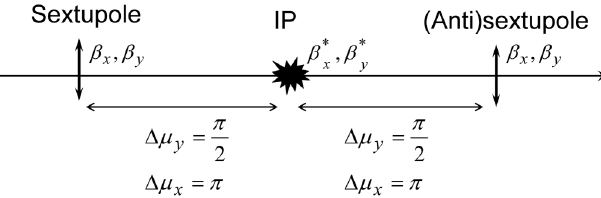
FIG. 1. Crab waist sextupoles